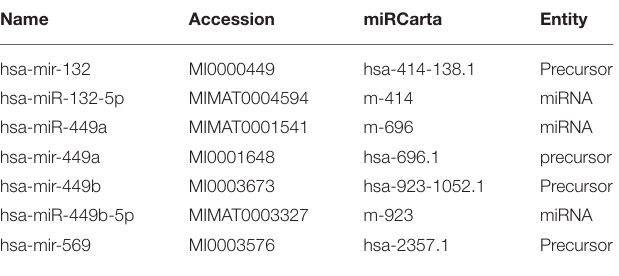
TABLE 2 | In silico analysis identifying miRs that contain the core AUUGUUA.